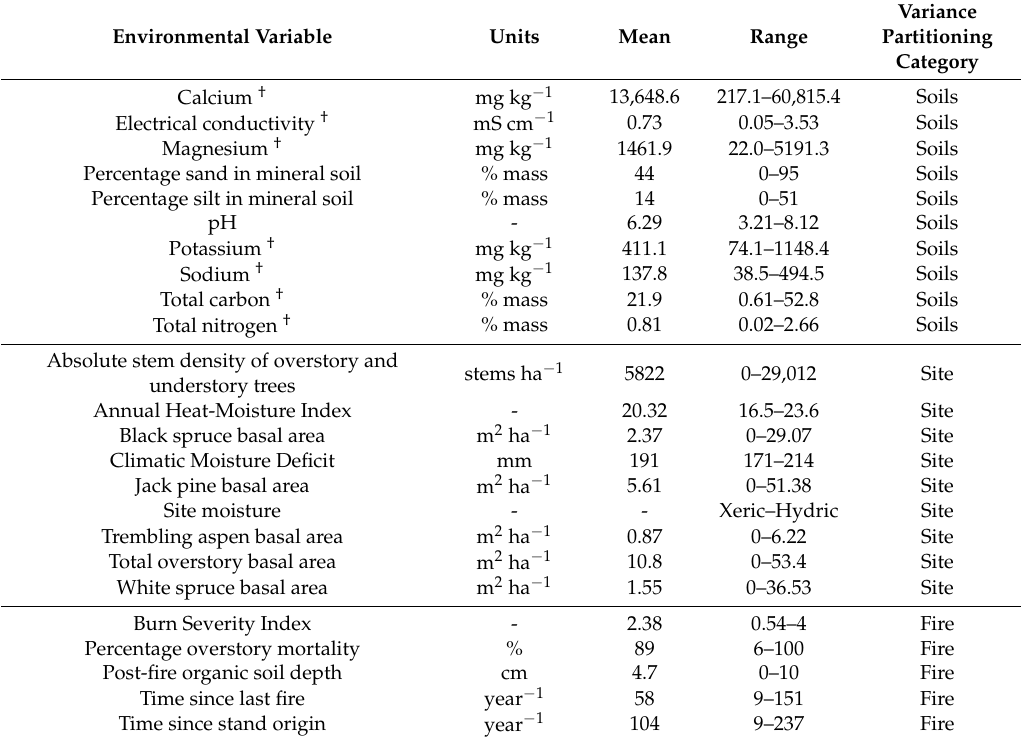
Table 2. Environmental variables incorporated in the explanatory variance partitioning of understory vegetation community dissimilarities and shifts in tree species dominance. Correlated soil properties collapsed with a principal components analysis for inclusion in variance partitioning are indicated with a † . Unitless variables are identified with a hyphen in the Units